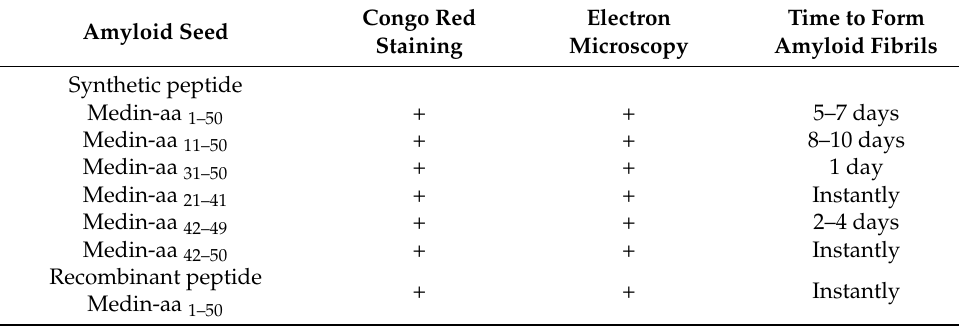
Table 1. Medin amyloid fibril formation in vitro. Amyloid